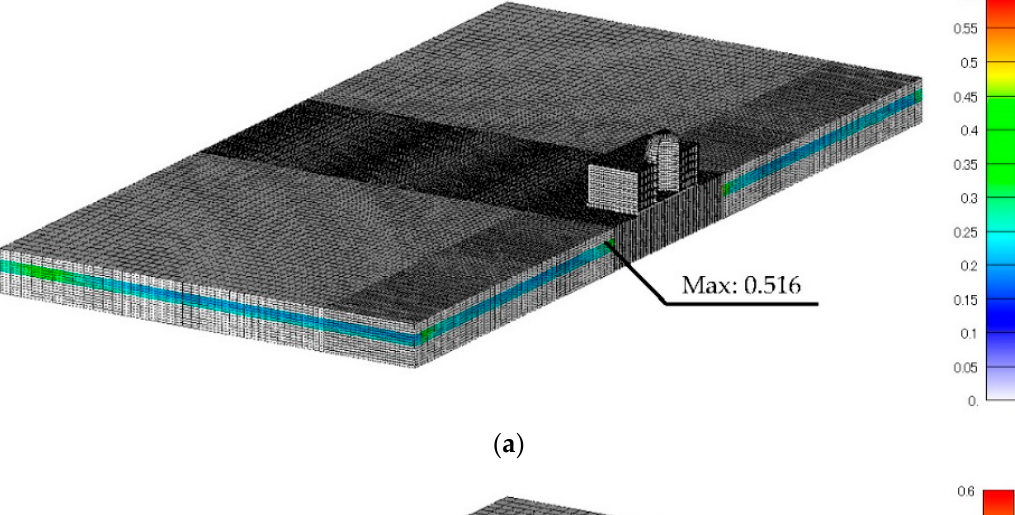
Figure 13. Shear strain distribution of ZX direction (15.36 s) in ( a ) the original model and ( b ) the proposed model.